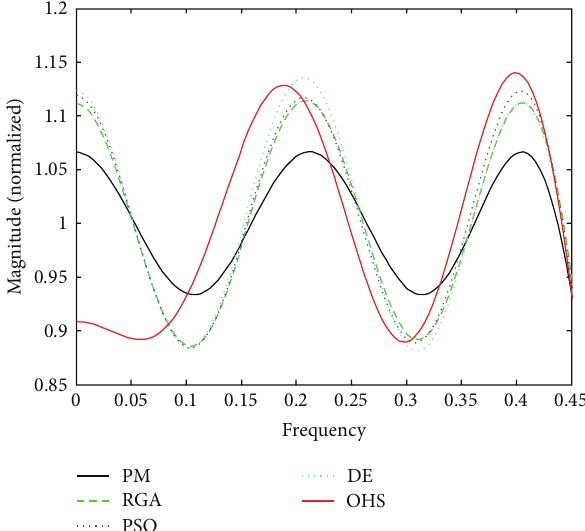
Figure 3: Normalized pass band ripple plots for the FIR LP filter of order